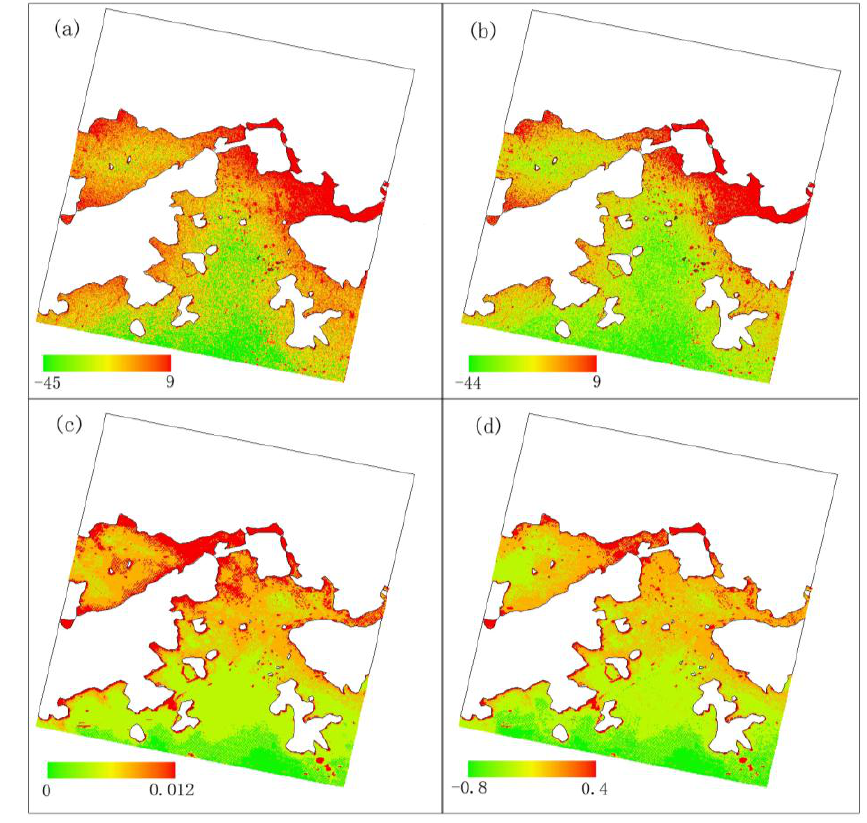
Figure 3. Distribution of four input variables in the same spatial resolution